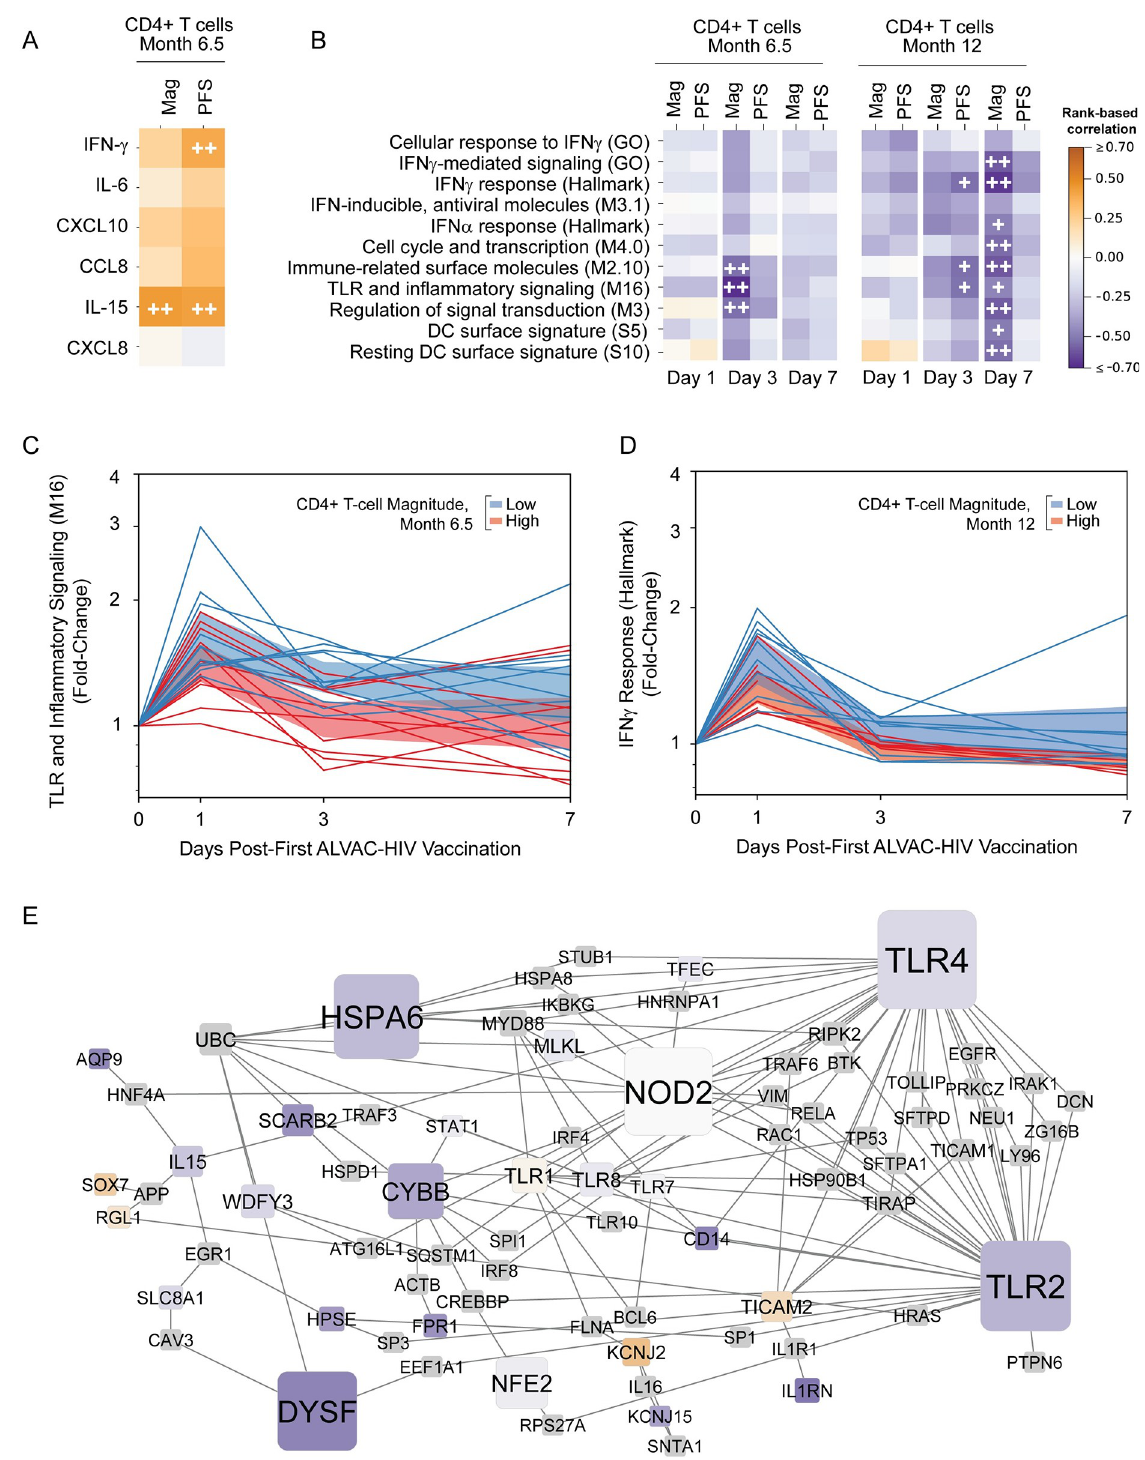
Fig 5. Rapid resolution of the early innate response is associated with higher CD4+ T-cell responses to HIV-1 Env at Months 6.5 and 12. A ) Heatmaps representing correlations between Month 6.5 Env-specific CD4+ T-cell magnitude (“Mag”) or polyfunctionality score (“PFS”) and Day 1 cytokine fold-change compared to baseline. FDR-q < 0.2 (+) or < 0.1 (++). B ) Heatmaps representing correlations between average module scores and Month 12 Env-specific CD4+ T-cell Mag and PBS. FDR-q < 0.2 (+) or < 0.1 (++). C, D ) “TLR and inflammatory signaling (M16)” ( C ) and “IFN γ response (Hallmark)” ( D ) module scores at Days 1, 3, and 7. Each line represents the module score for 1